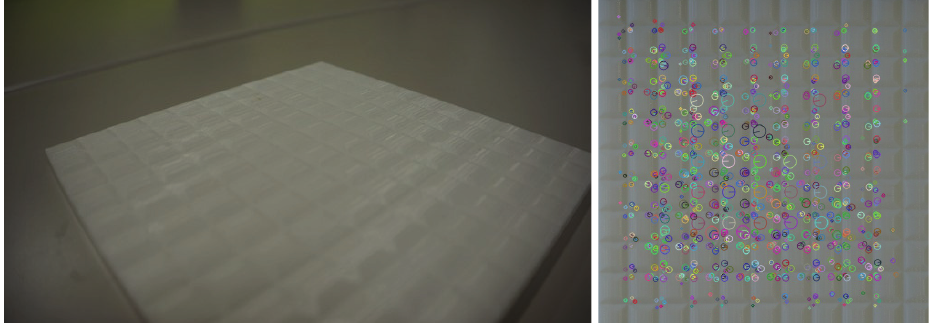
Figure 4. Left: self-made texture, right: image features acquired by AKAZE.